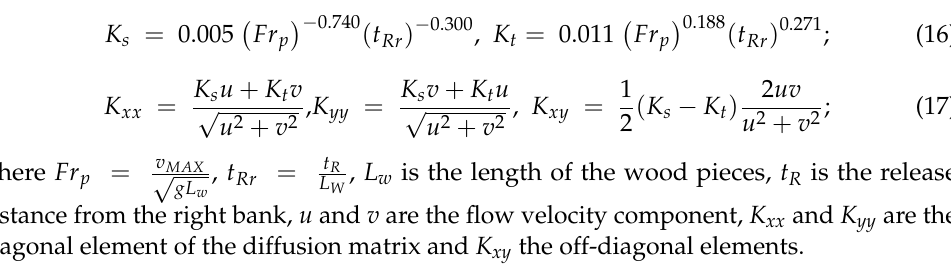
Table 1. Summary of the main parameters of the experiments.